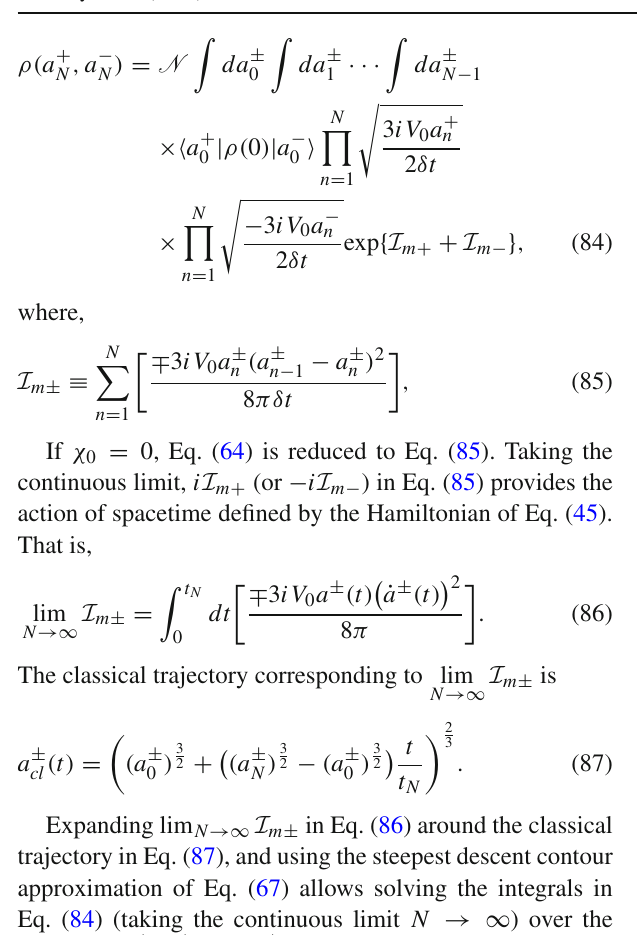
scale factor) are shown in Fig. 9. In this figure, the differ- ent colors represent the various diagonal elements ρ( a , t ) in Eq. (92). The black curve represents the classical trajec- tory of the universe driven by non-relativistic matter. Figure 9